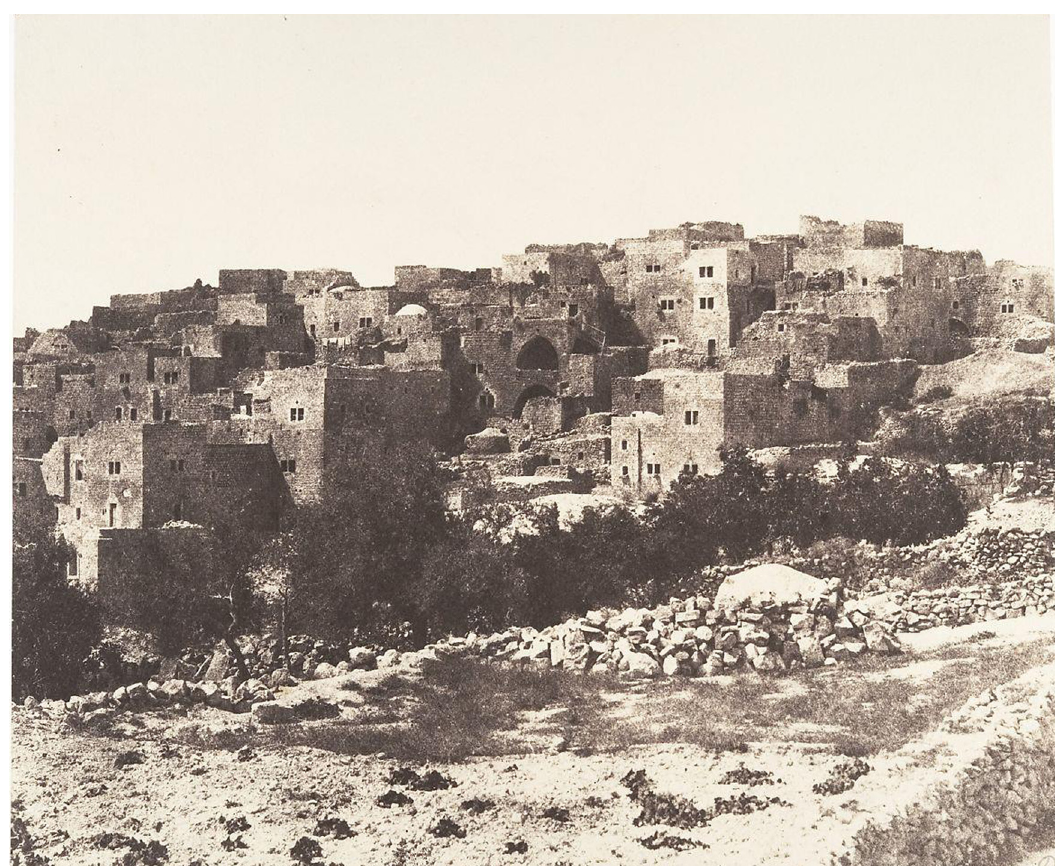
Figure 9: Auguste Salzmann, Bethlehem ,